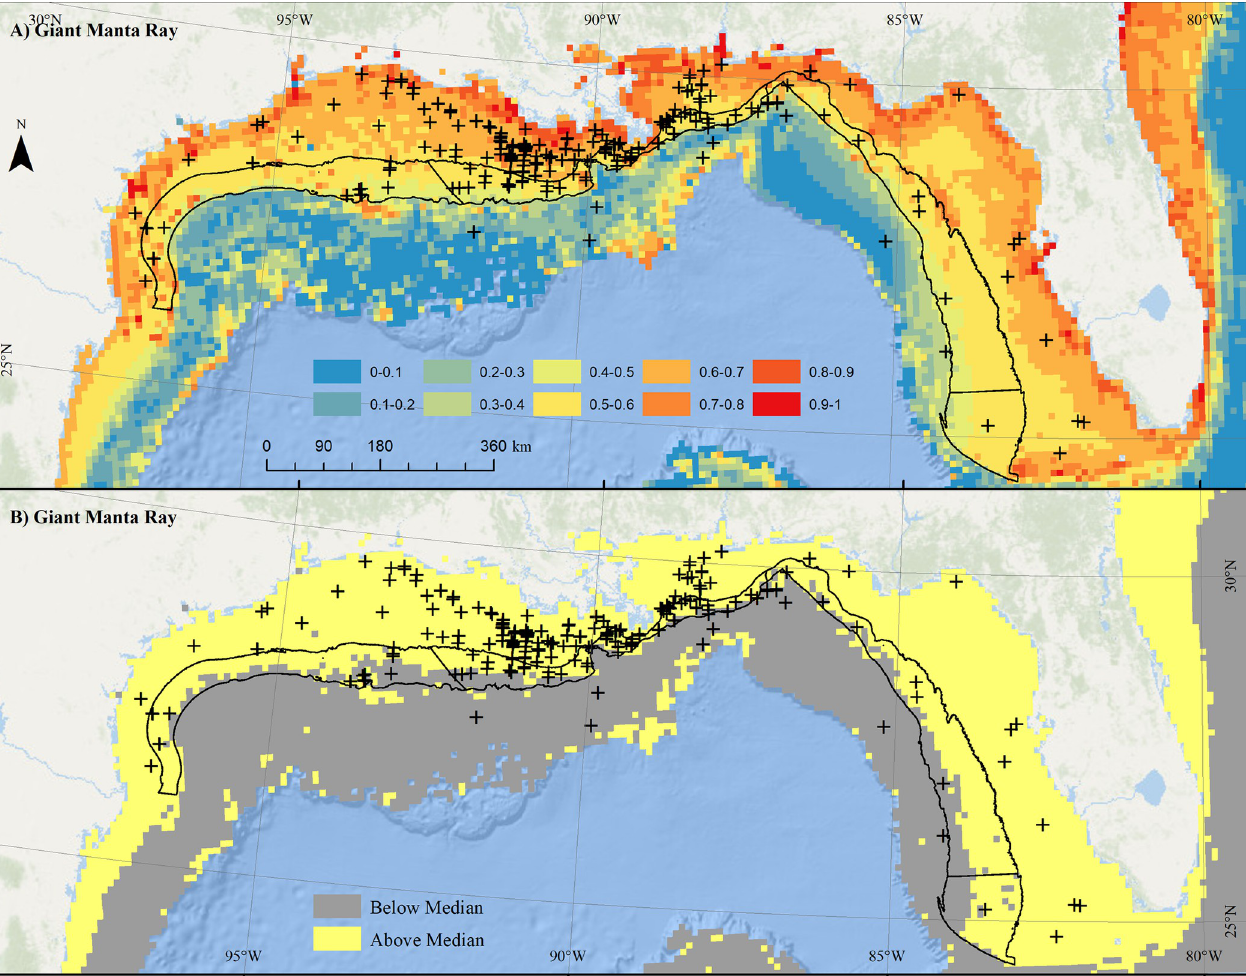
Fig 6. Distribution of giant manta ray. Map of A) maximum monthly predicted probability of giant manta ray observation fit to environmental data from January 2003 to December 2019, overlaid with giant manta ray sightings from 1925–2020, and B) areas falling above (yellow) and below (gray) median predicted probability of occurrence values. Black border denotes proposed aquaculture study areas. Map developed in ESRI ArcGIS 10.8.1. Basemap from Esri Ocean Basemap and its partners, reprinted from ESRI under a CC BY license, with permission from ESRI, original copyright 2022. Projection: UTM NAD83 Zone